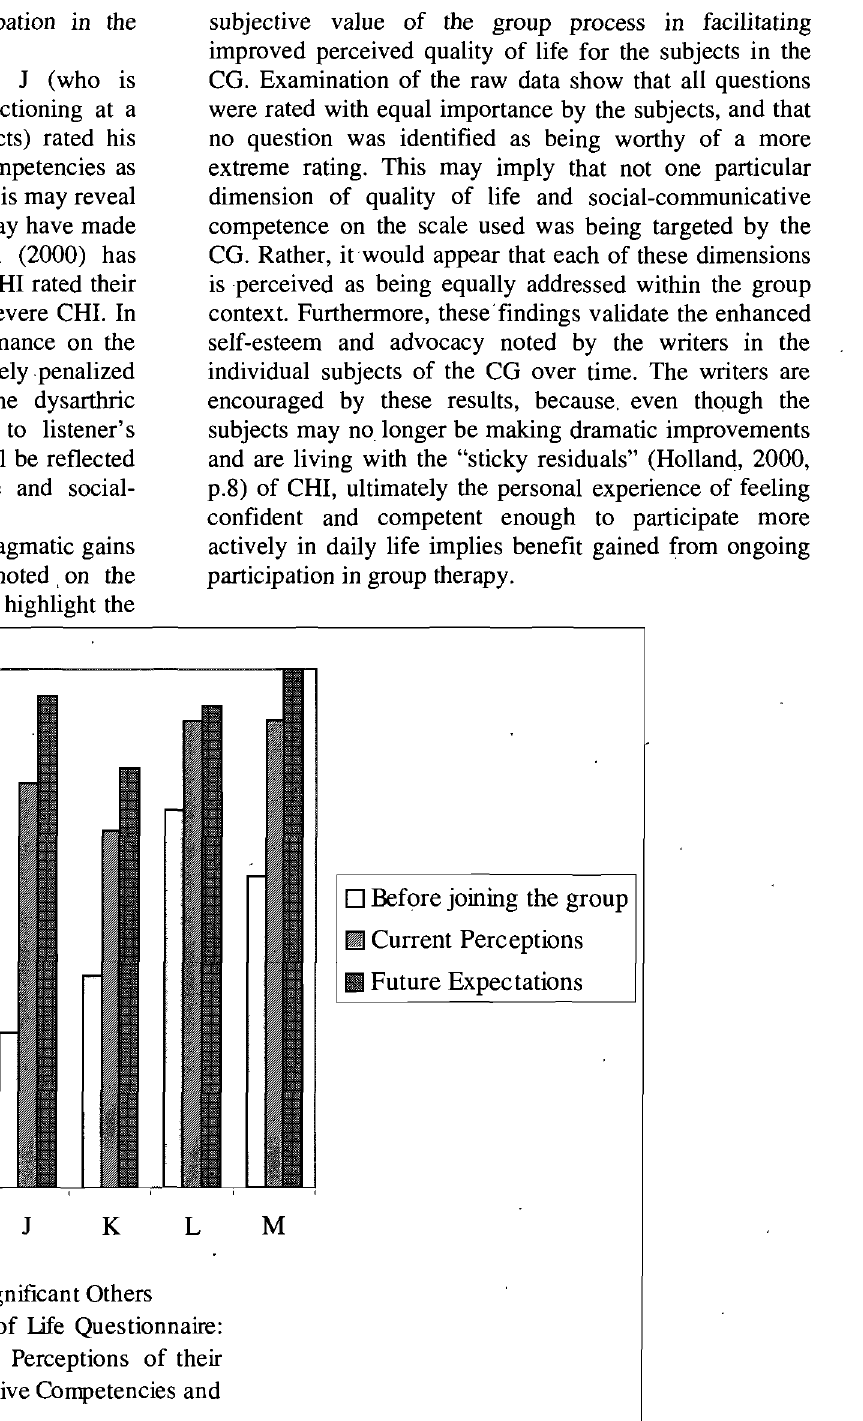
i Significant Others ! Figure 5: Quality of Life Questionnaire: I Significant Others' Perceptions of